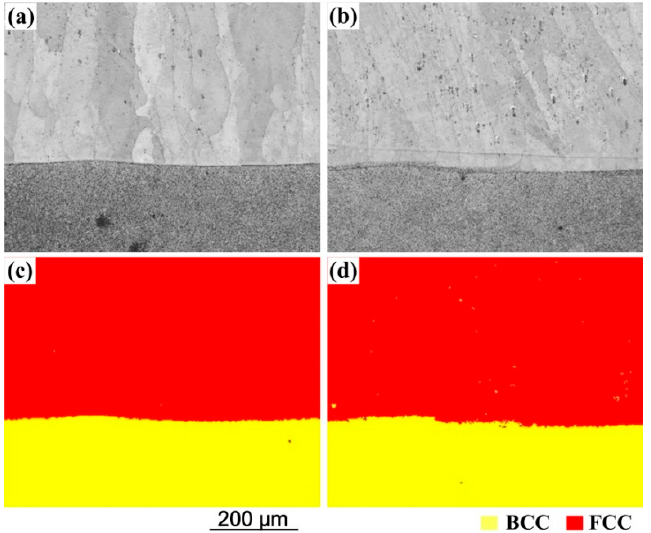
Table 1. Chemical composition of X65 steel substrate.